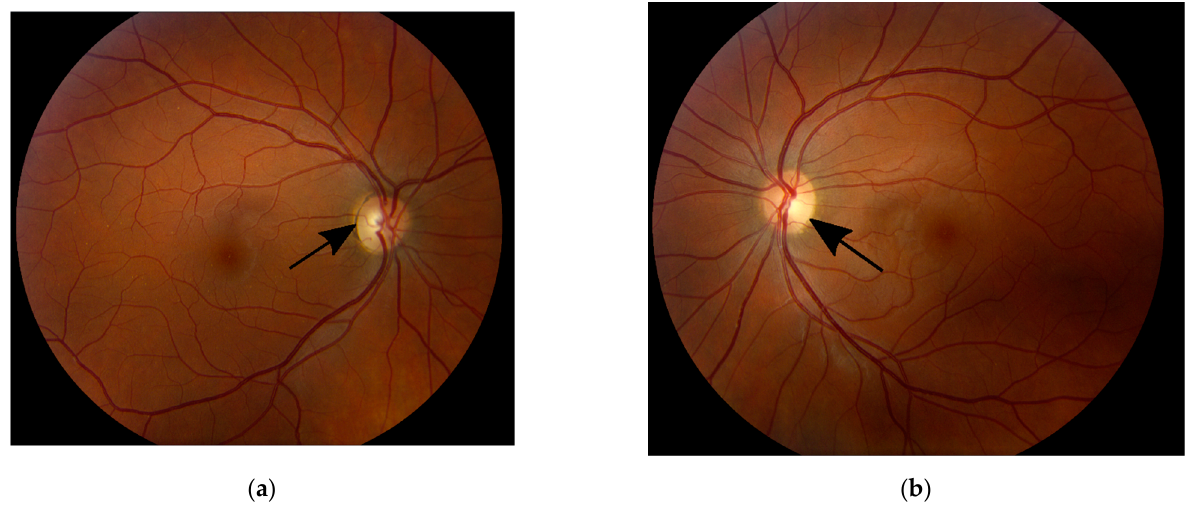
Figure 4. Fundus photos of the right ( a ) and left ( b ) eyes of the mother showing mild temporal optic disc pallor in both eyes (black arrows).